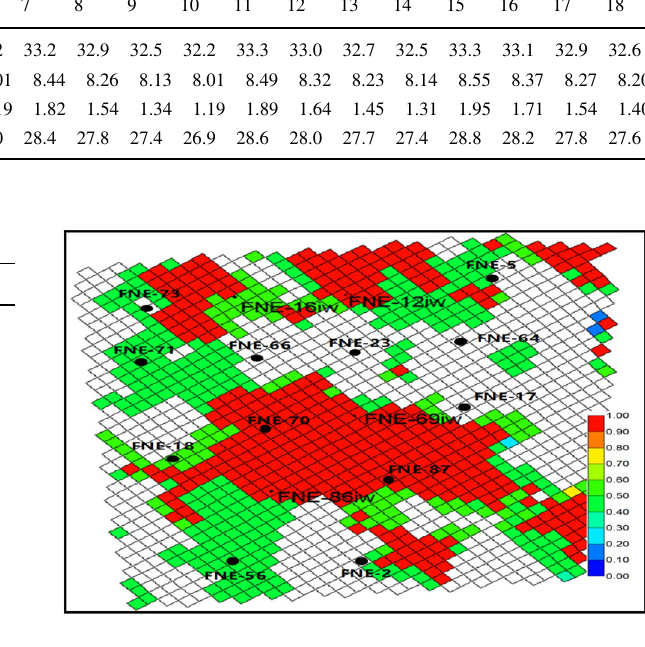
Fig. 10 Net gross of (B1a and B1b) layers